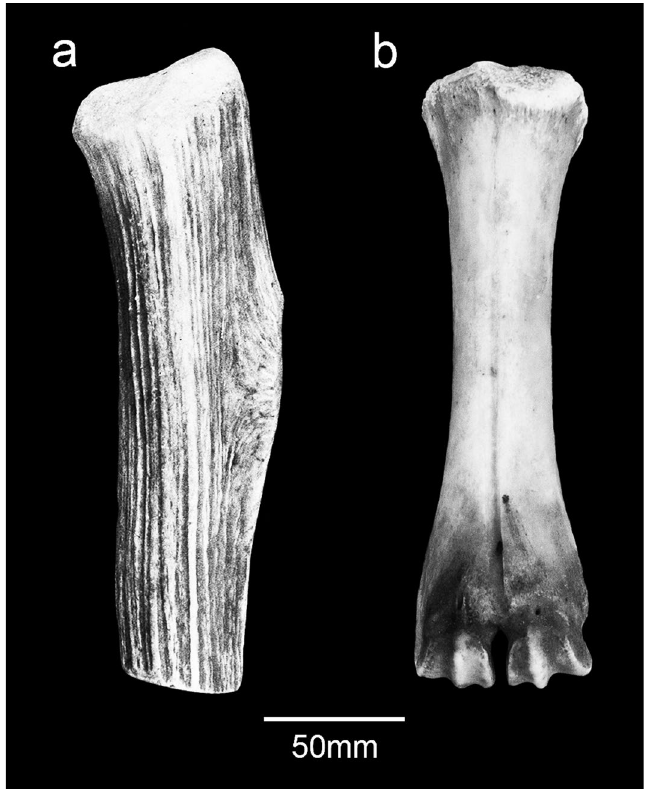
Figure 9. Antler ( a ) and cattle metacarpal ( b ) used as hammers in experiments to knap handaxes. Note the similarity in the distribution of attrition and rounding of the proximal end of the cattle metacarpal with that of the bison metatarsal from Clacton (Fig.